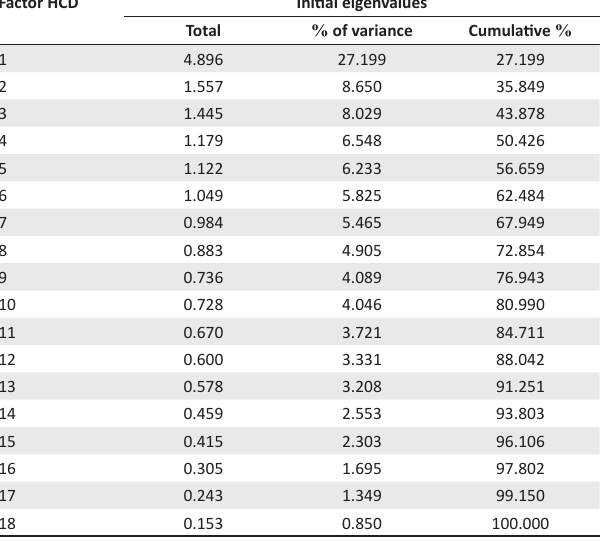
TABLE 6: Initial eigenvalues human capital disclosure (first-level factor analysis). Factor HCD